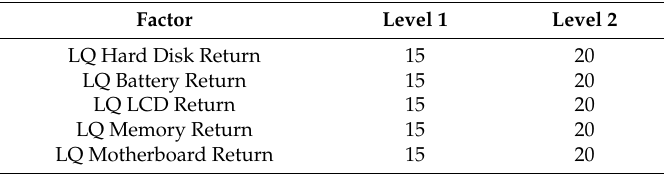
Table 5. Low-quality subassembly and component probabilities (%).